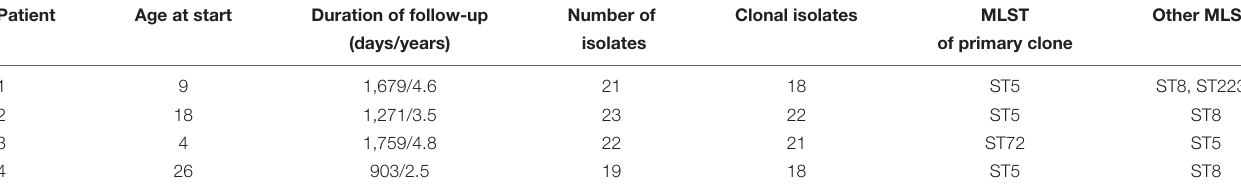
TABLE 1 | Patient demographic information and S. aureus molecular characteristics.